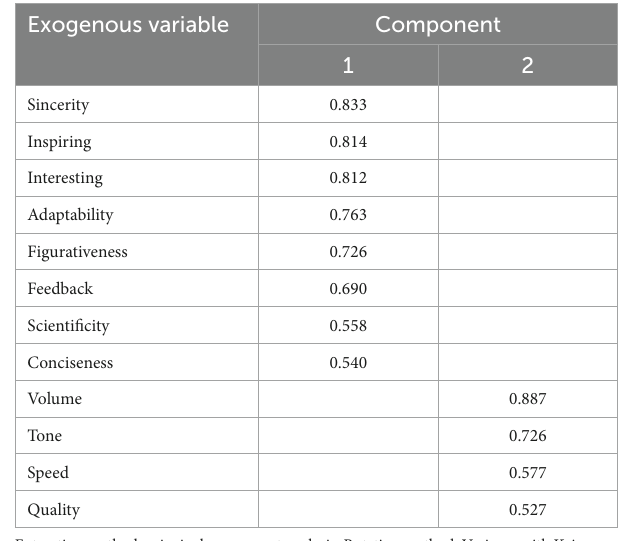
TABLE 5 Rotated component matrix. a